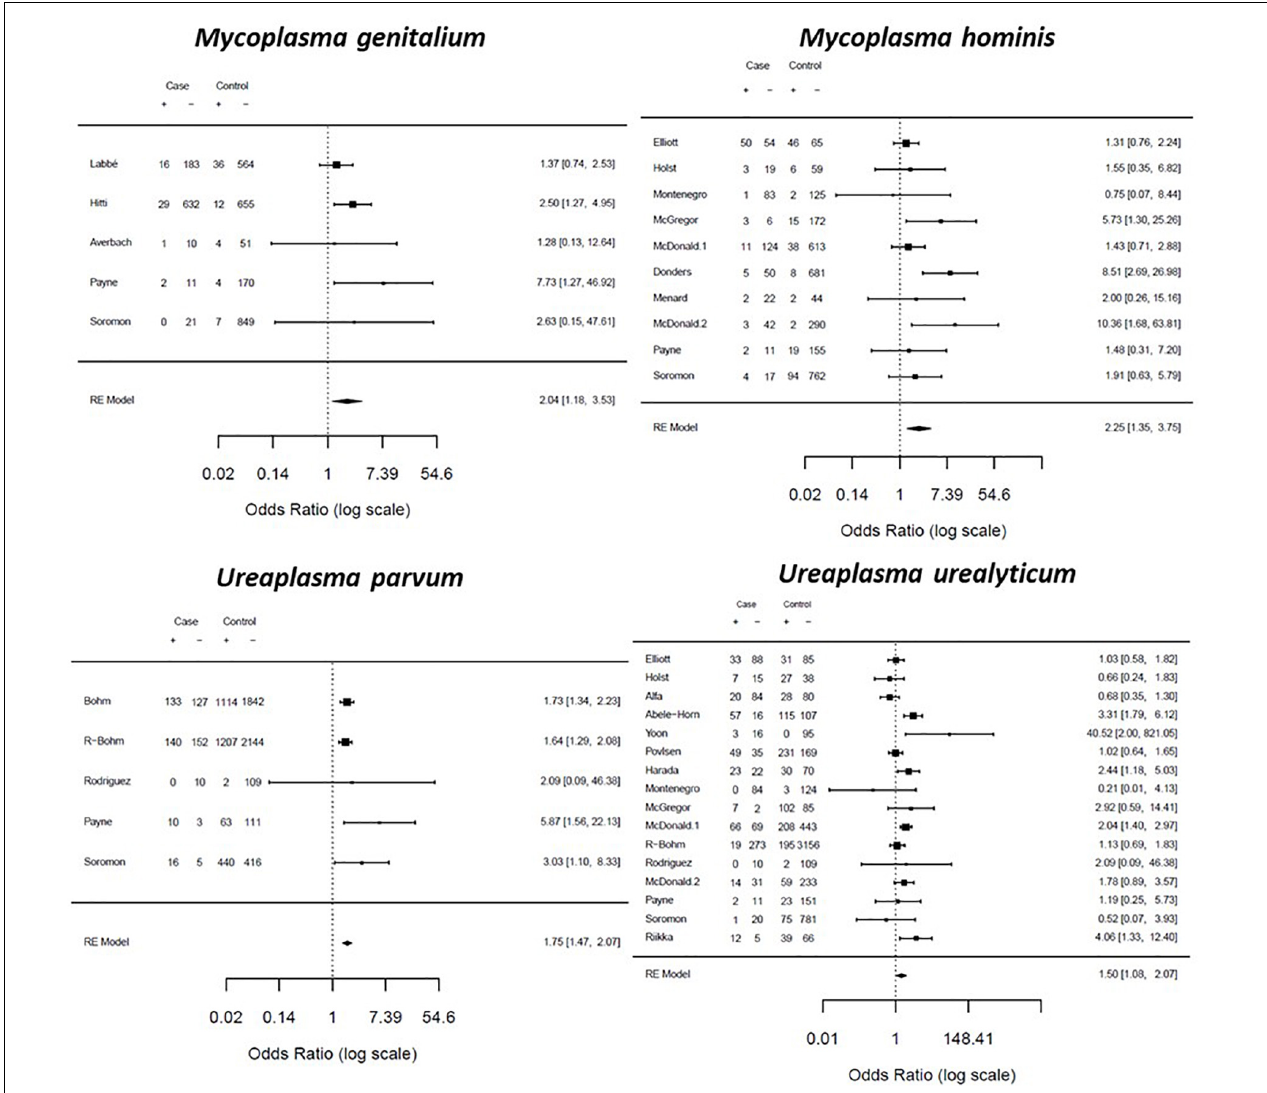
FIGURE 7 | Forest plot for the association between genital Mycoplasma infection and preterm delivery. Effect sizes were presented as pooled odds ratio with 95% confidence